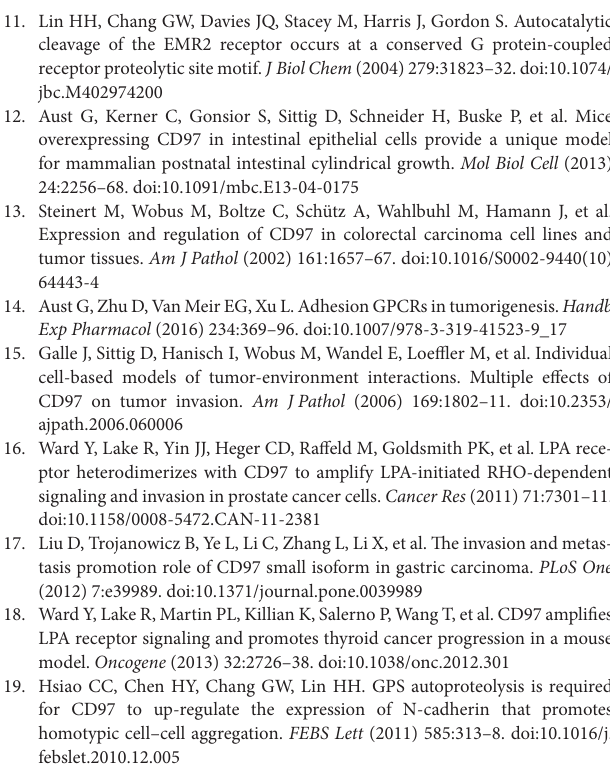
FigUre s1 | Adenomatous polyposis coli (APC): β -catenin interaction verified by proximity ligation assay (PLA). Co-immunohistology (IH) of both, APC and β -catenin, was performed after PLA by detecting the primary antibodies (Abs) with fluorochrome-labeled secondary Abs. Merged pictures localized PLA interaction spots in the immunostained sections. (a) Normal colon: APC: β -catenin interaction was restricted to intestinal epithelial cells. (B) Colorectal